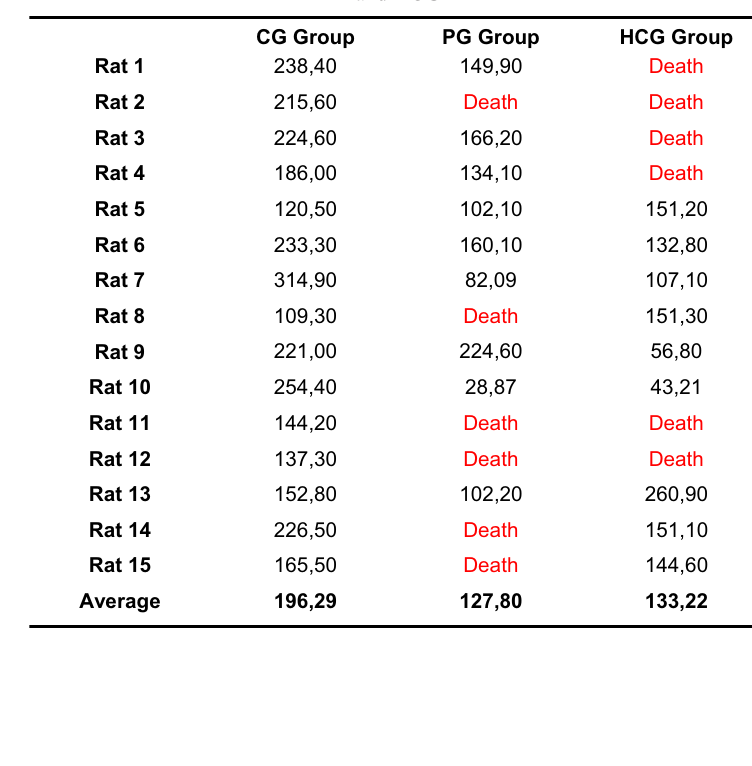
TABLE 1 - Values of Total Energy Rupture, in gf.cm, in the animals of CG, PG and HCG